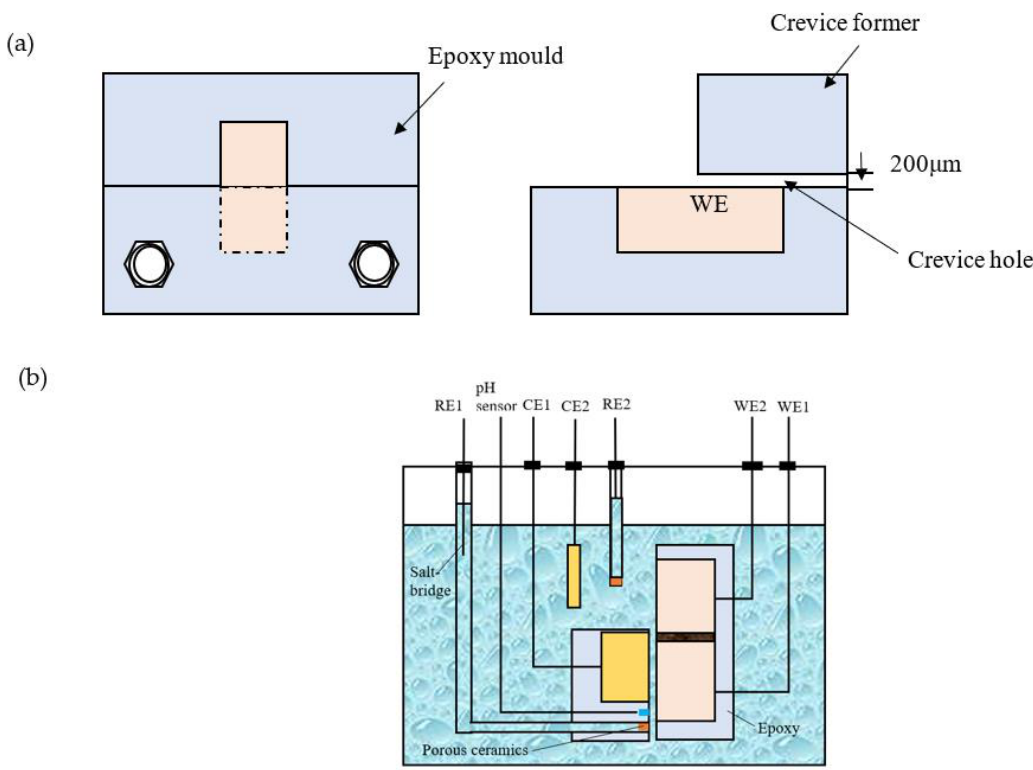
Figure 1. Configuration of the crevice and sketch map of the setup. ( a ) Crevice configuration for morphology analysis; ( b ) crevice configuration and sketch map of the setup for electrochemical tests.